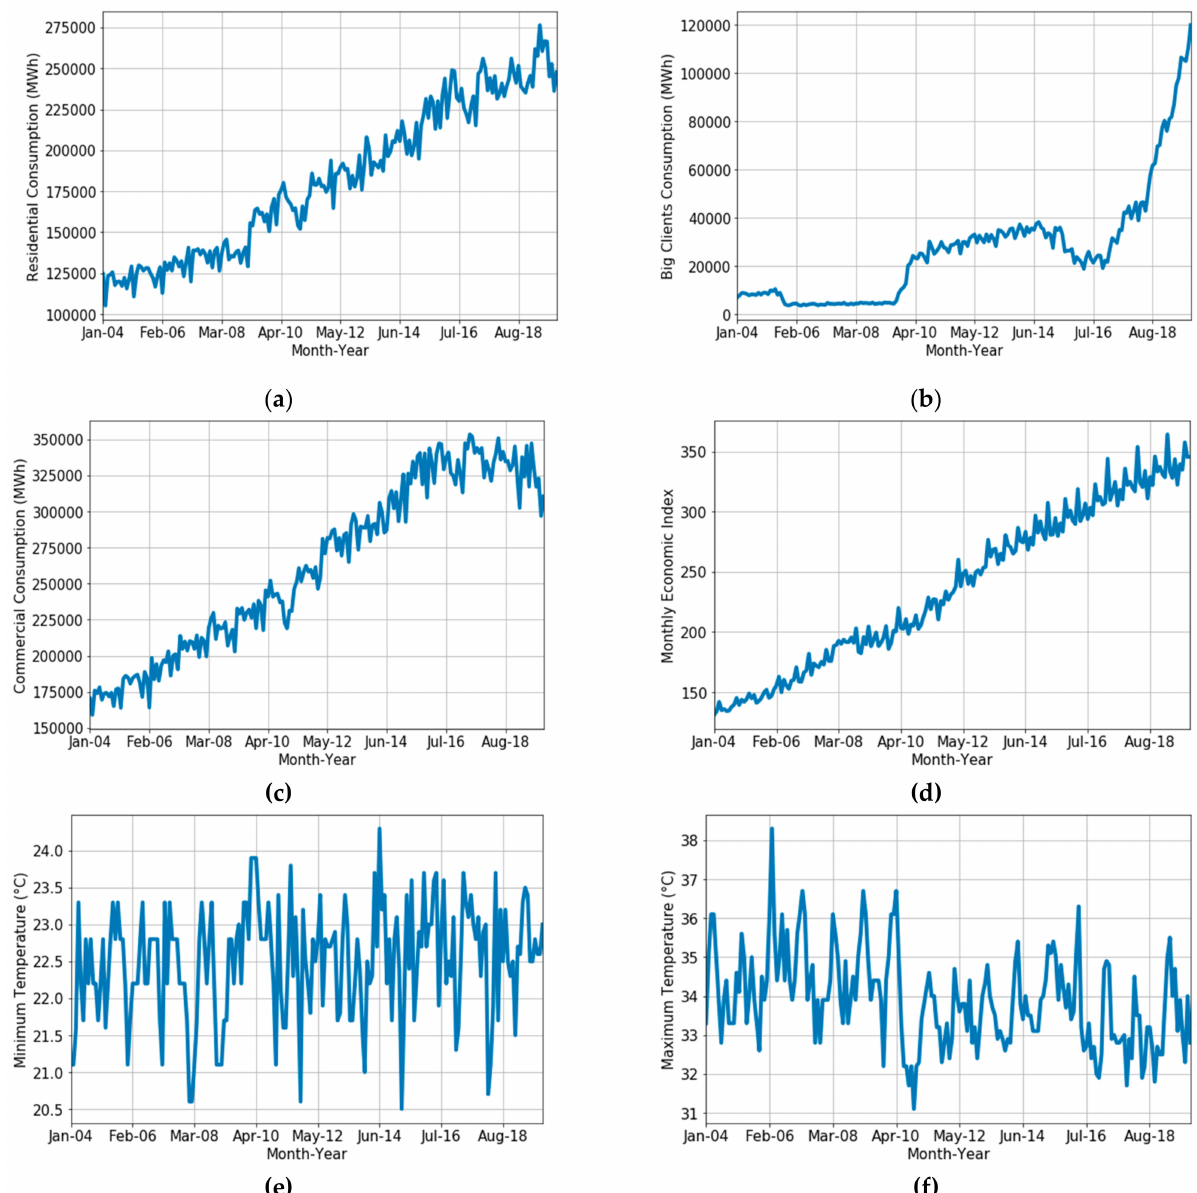
Figure 8. Comparison of the input variables trend for predicting peak demand ( a ) Residential consumption; ( b ) Big clients consumption; ( c ) Commercial consumption; ( d ) Monthly economic index; ( e ) Minimum temperature, and ( f ) Maximum